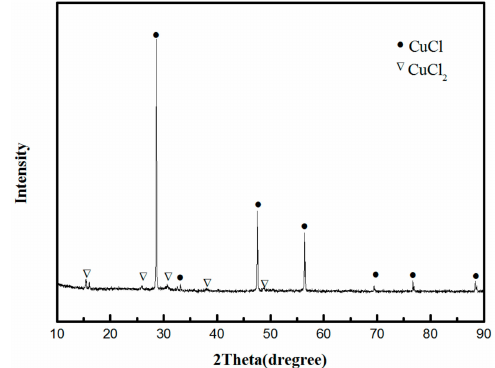
Figure 6. XRD study of heating product (450 ◦ C) of the